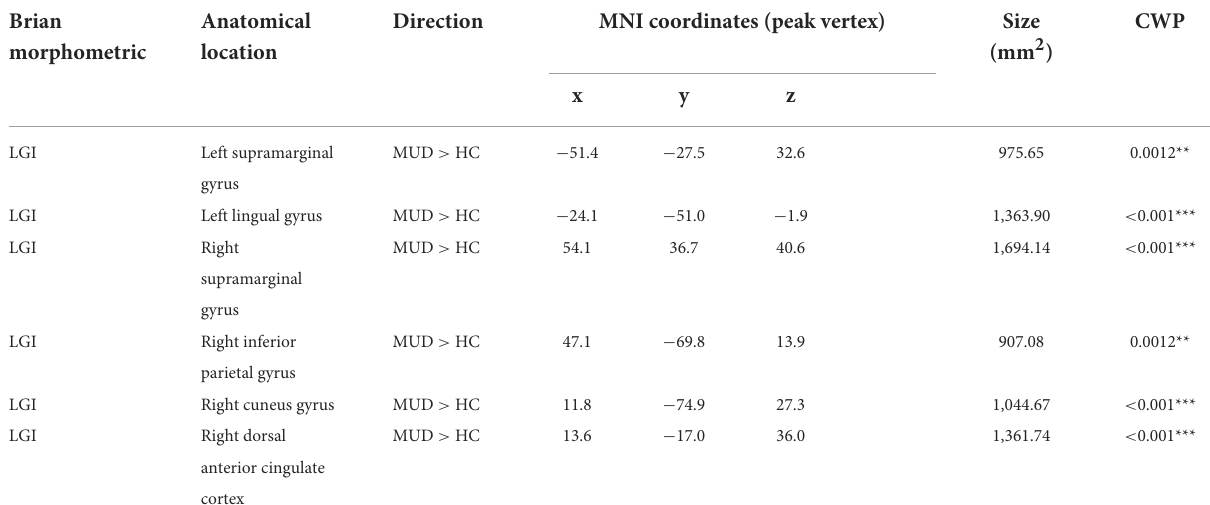
TABLE 2 Significant group differences in brain morphometry between the abstinent males with methamphetamine use disorder and HCs. Significant group differences in LGI with age, education years, and ICV as covariates